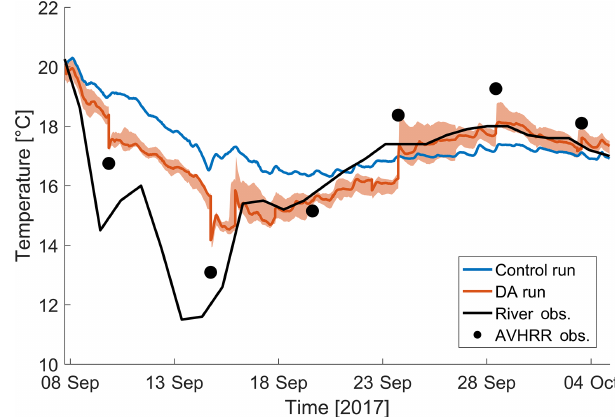
Figure 6. Close-up of the upwelling event in mid-September. River temperature from the lake outlet in Geneva is added as a compari- son. The AVHRR data (black dots), control run (blue), and DA run (red) correspond to a surface pixel 3km from the